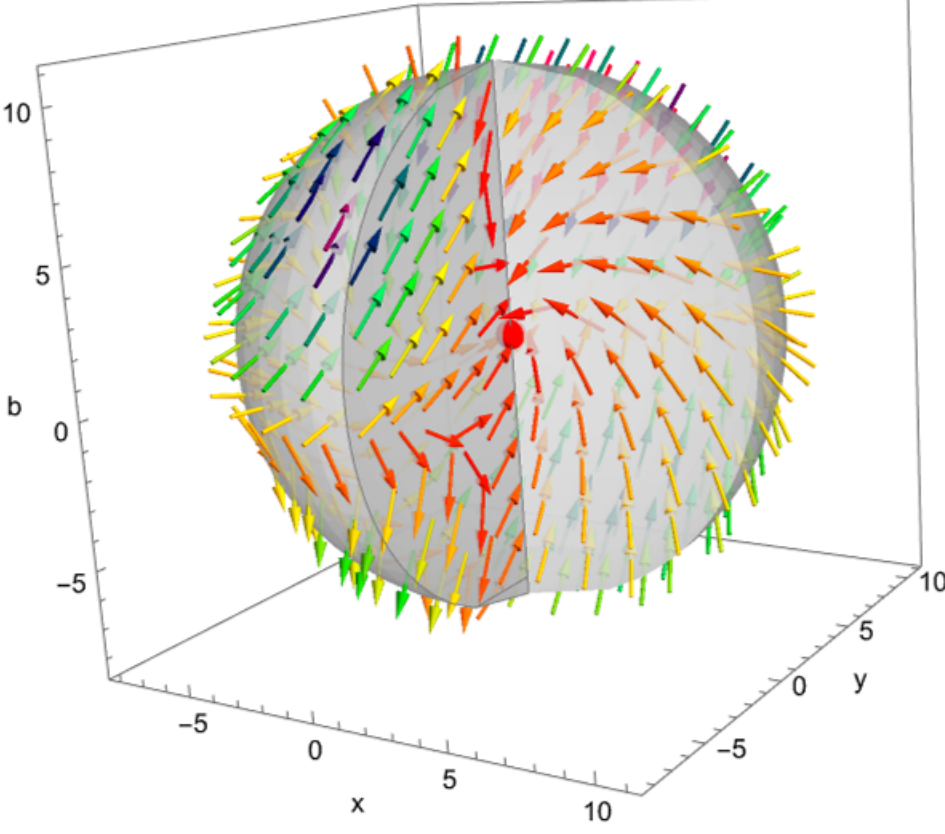
Figure 3. Directional fields for the ODEs of RM2 with x , y , and b being variable and a being fixed. The steady state is marked with a red sphere in the middle of the 3D plot. The region of interest is the lower part of the surface where the stream lines are coming out of the